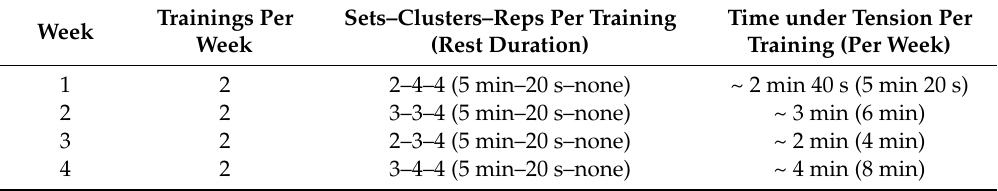
Table 1. Eccentric–isokinetic training protocol. Sets, clusters, repetitions (reps), rest duration, and time under tension (mean duration per rep ~ 5 s) for the four-week eccentric–isokinetic training for the swallow and support scale